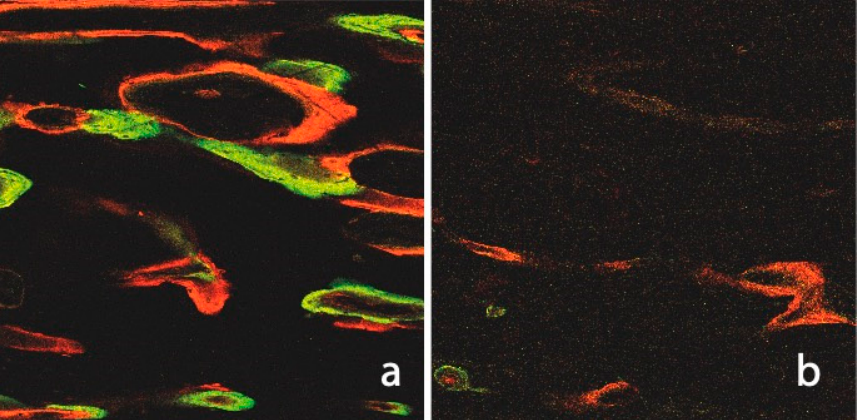
Figure 7. Fluorescence image of a non-irradiated and ultrasound of untreated native tibia ( a ). The numerous Haversian and Volkmann channels, as well as the intense label integration (CAL and ALZ), are notable when compared to the irradiated cortical bone ( b ).